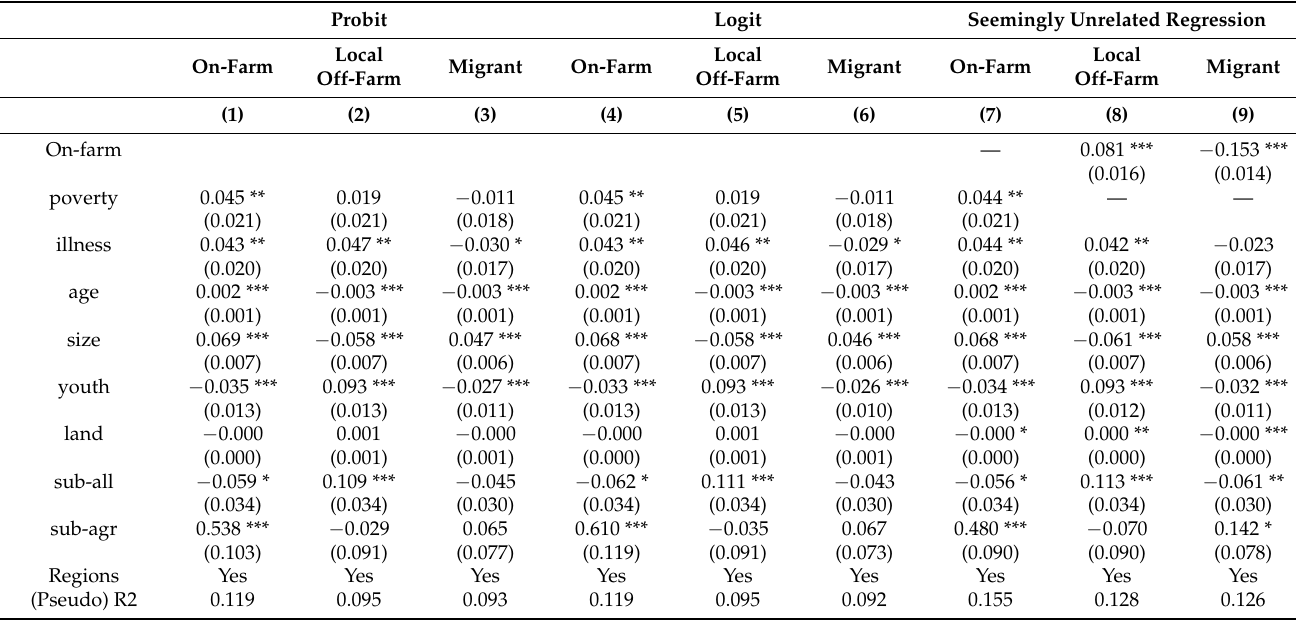
Table 3. Chronic illness and livelihood strategies.